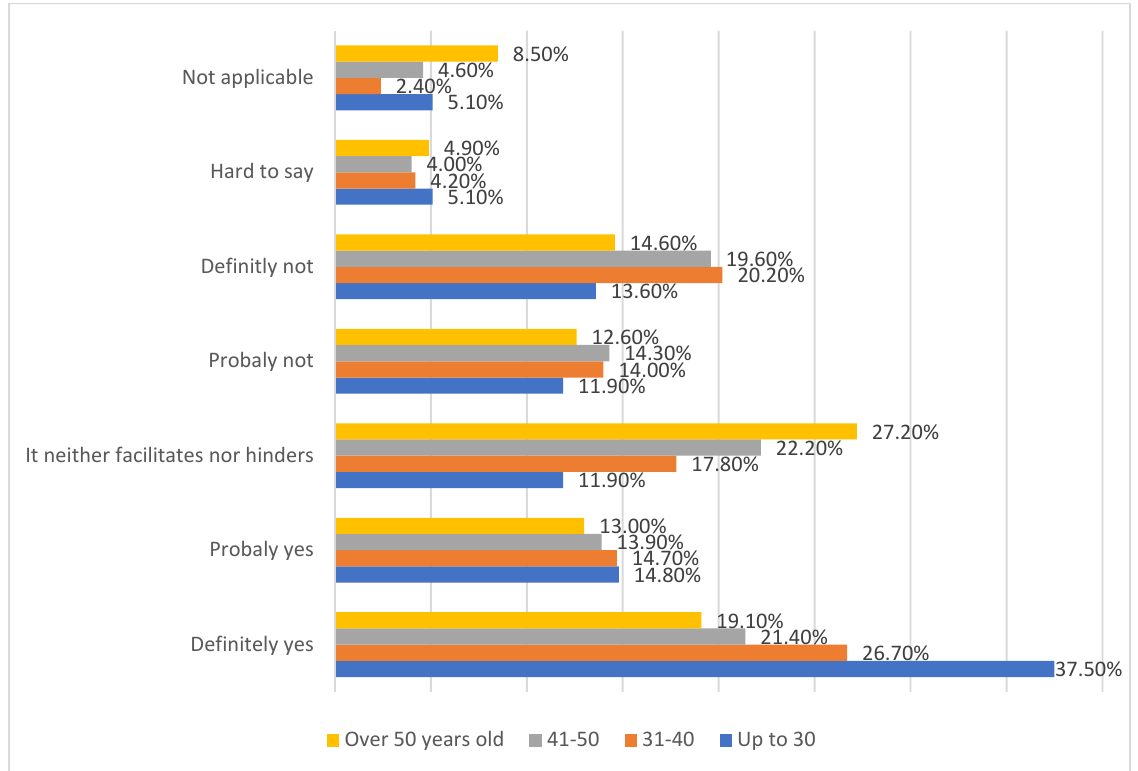
Figure 1. Assessment of the operation of educational and upbringing institutions from the point of view of caring for child/children (age)(n = 7800). Source: Authors’ calculations. Note: Pearson’s chi-square test for “Age” resulted in 116,541; df 18.